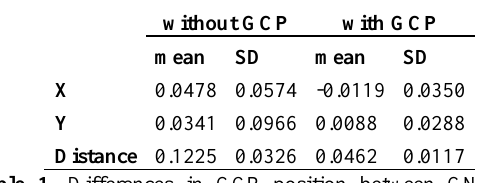
Table 1. Differences in GCP position between GNSS and